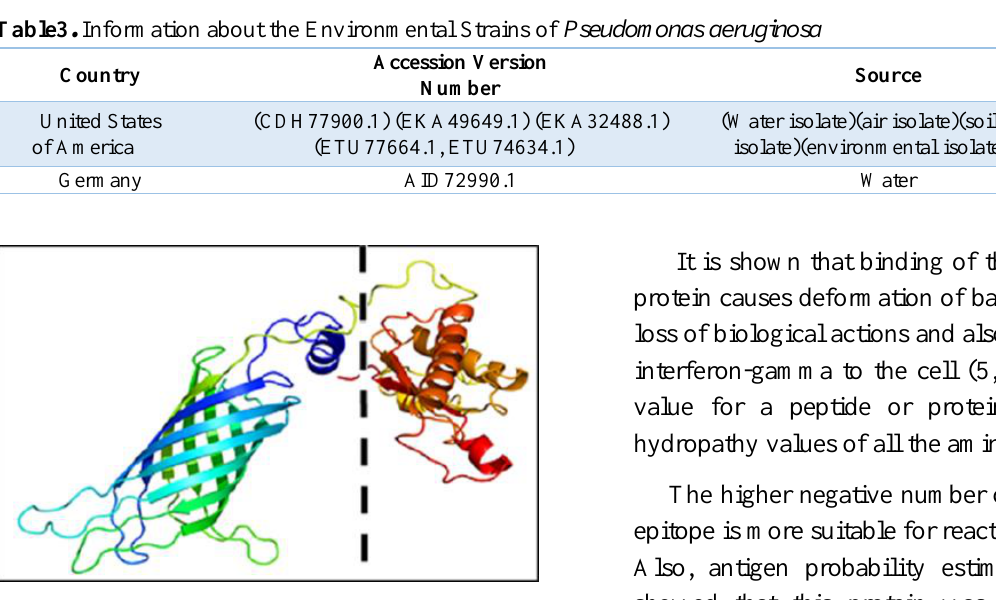
Fig 1. 3D structure of OprF